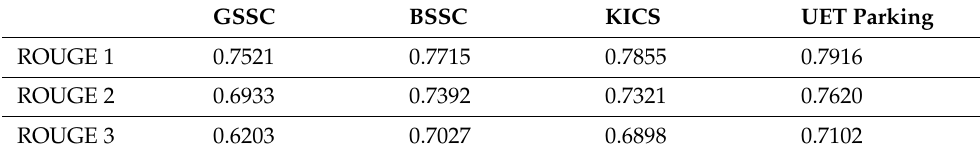
Table 3. ROUGE scores for the multitask deep learning framework for the UETVS dataset.